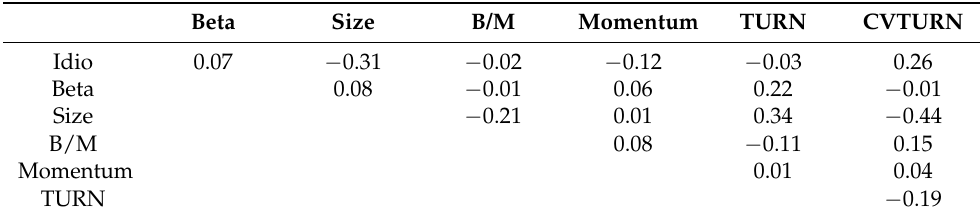
Table 4. Correlation matrix. This table shows the time series average of correlations among the control variables in the analysis for the period of July 1963 to December 2019. Beta is the stock-level market beta estimated from 60-month rollover regressions. Size and B/M are size and book-to-market ratio in Fama and French (1992). Momentum is the compound gross return from month (t − 7) to (t − 2). TURN and CVTURN are the average volume turnover and coefficient of variance of TURN calculated over the past 36 months in Chordia et al. (2001). The idiosyncratic risk (Idio) is the standard deviation of regression residuals of daily stock returns in month t −